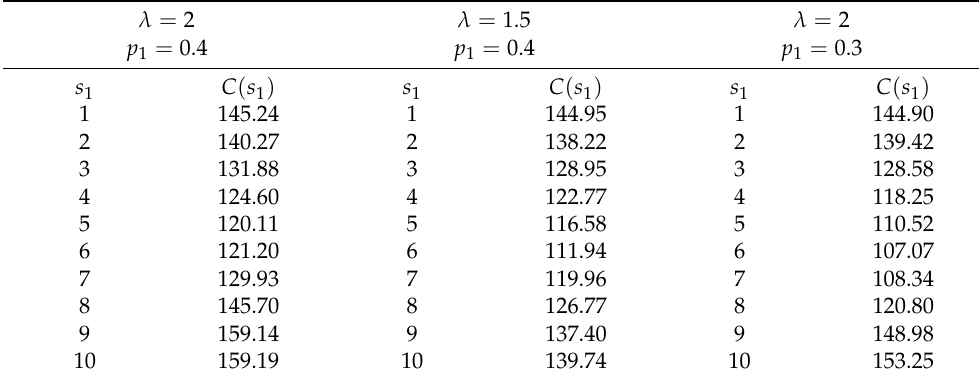
Table 2. The total operating cost C ( s 1 ) under different s 1